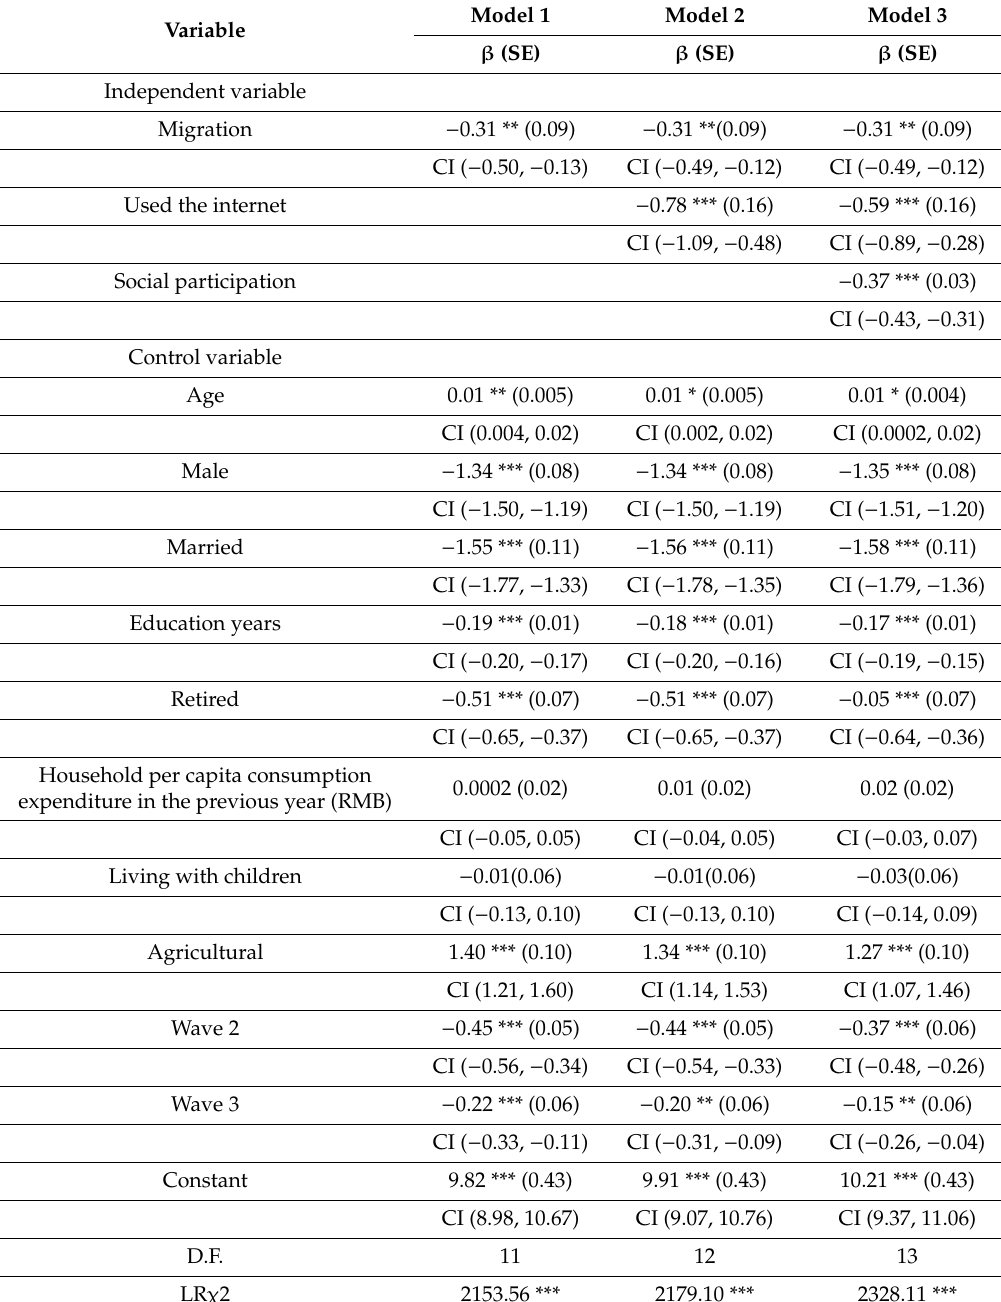
Table 2. Random-effects models predicting depressive symptoms ( n old adults = 18,511, n observations =